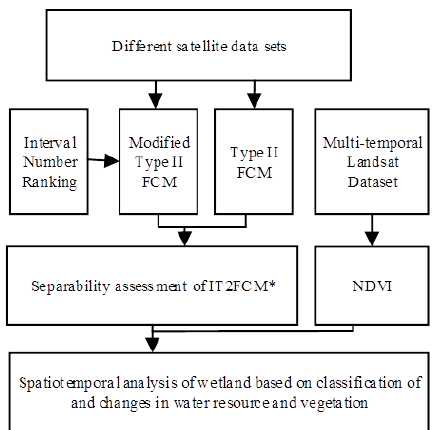
Figure 3. Flowchart of the spatiotemporal analysis of the wetland based on long-term series of Landsat satellite data.